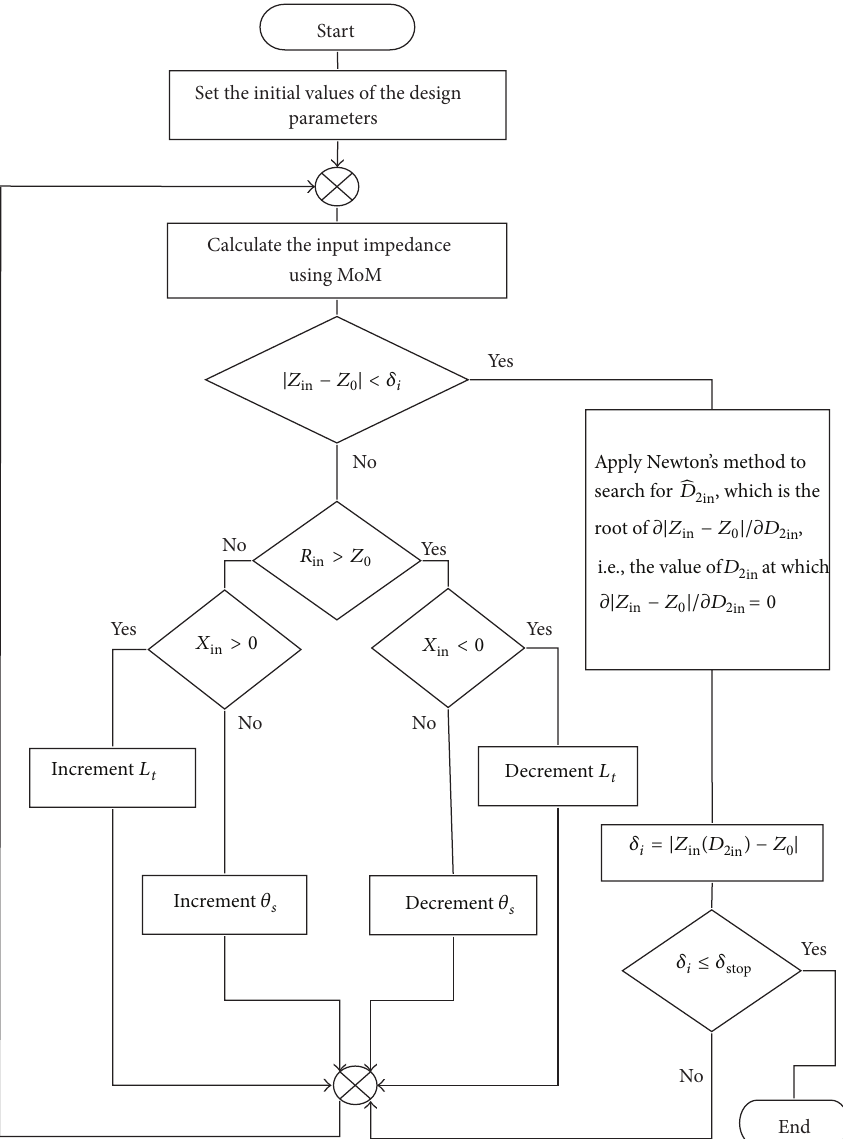
Figure 6: Flow chart for the optimization procedure to arrive at the dimensional parameters 𝐿 𝑡 , 𝜃 𝑠 , and 𝐷 2 a coaxial feeder of characteristic impedance and balanced